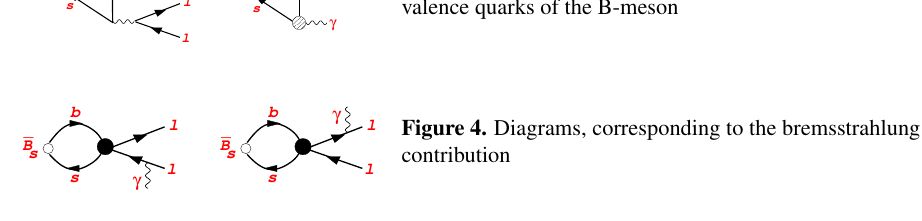
Figure 4. Diagrams, corresponding to the bremsstrahlung contribution